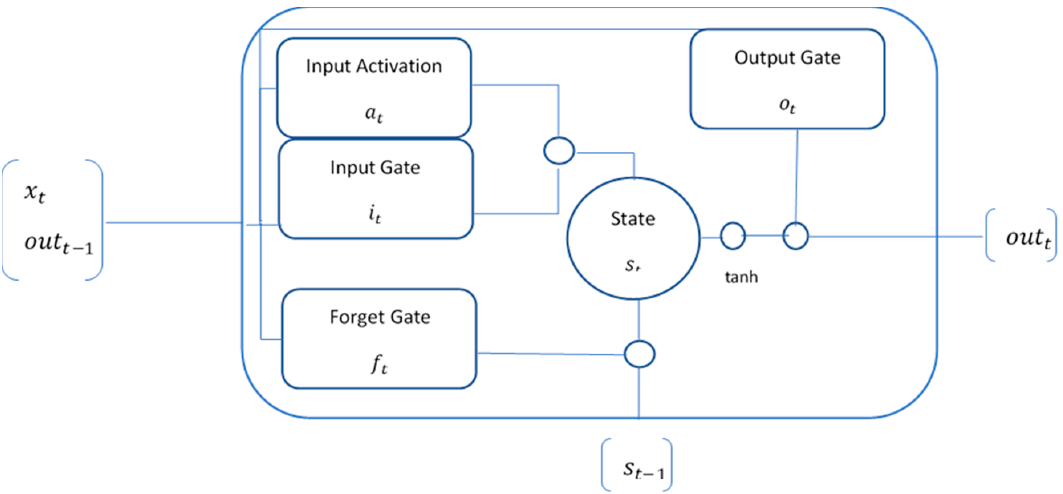
Figure 1. High level pictorial representation of a Long Short Term Memory (LSTM) memory cell.